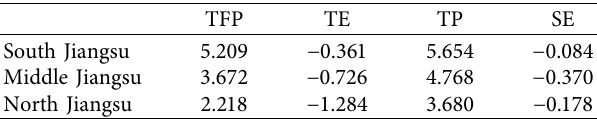
Table 3: The accumulative change situation of TFP, TE, and SE in three regions of Jiangsu from 2000 to